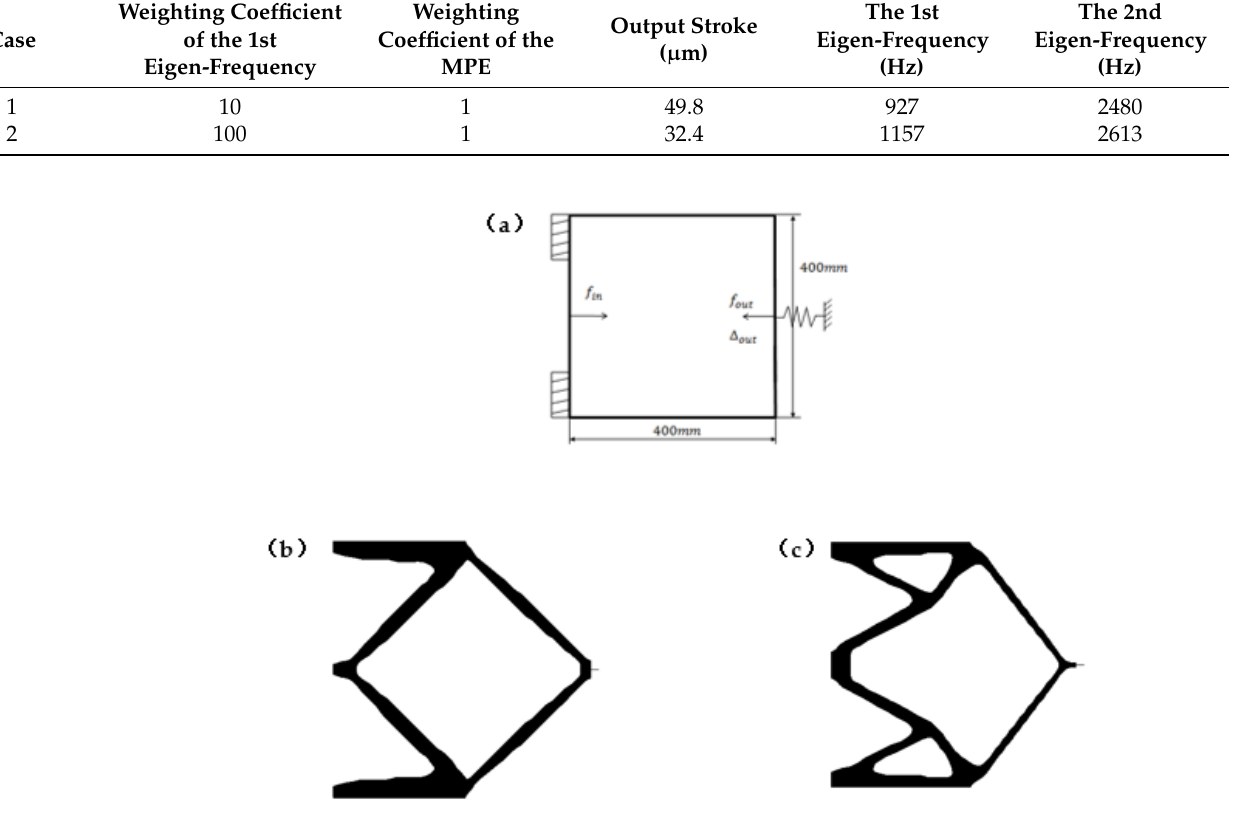
Table 2. Two types of optimized result with different weighting coefficient of the 1st eigen-frequency.